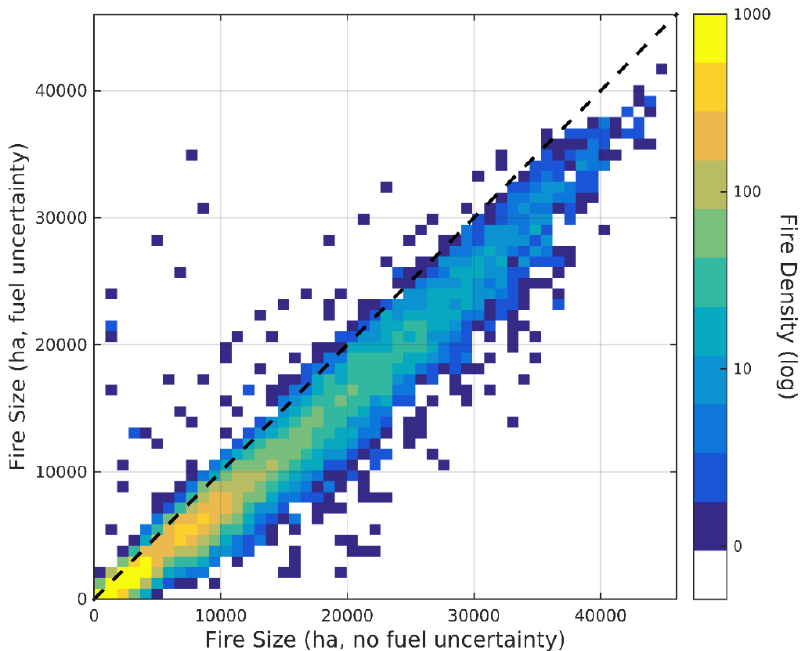
Figure A3. Estimated fireshed (historical calibration period) and the observed wildfire footprint between 1980 and 2017.